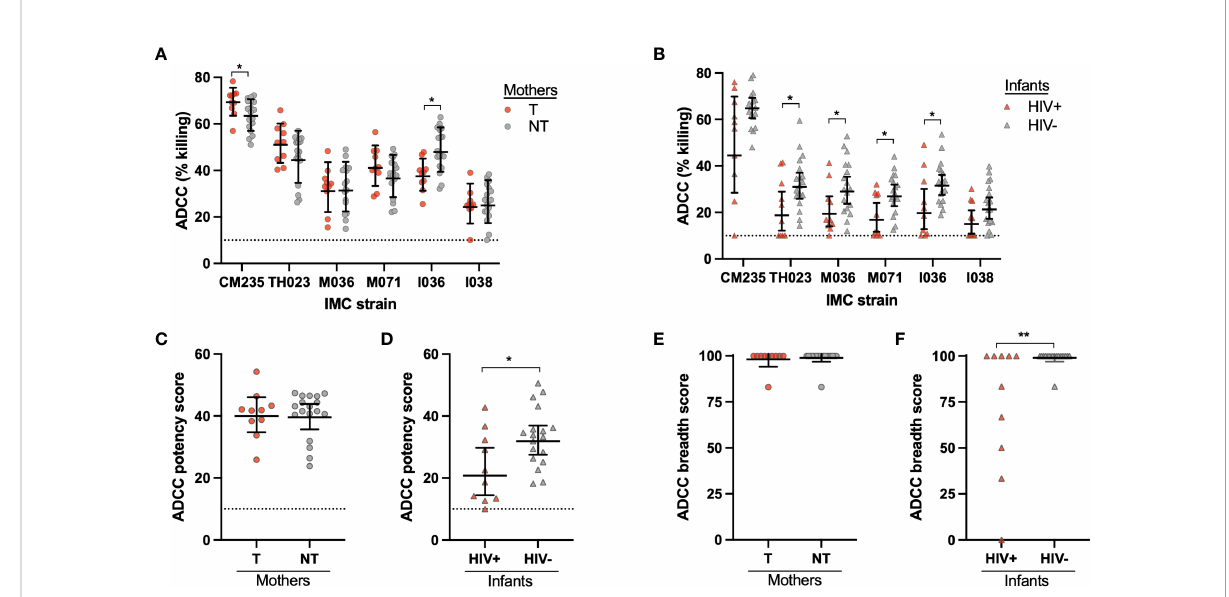
FIGURE 1 Mother and infant plasma ADCC activity. ADCC activity was measured for the (A) transmitting (T) and non-transmitting (NT) mothers and (B) HIV + and uninfected (HIV-) infants using six CRF01_AE HIV strains in the ADCC-Luciferase assay. CRF01_AE HIV IMC strains CM235, TH023, M036, M071, I036, and I038 were used; M036 and M071 were originally isolated from the maternal cohort, and I036 and I038 were originally isolated from the infant cohort. The ADCC potency was calculated as the geometric mean of ADCC % killing for all IMC strains for the (C) mothers and (D) infants. The ADCC breadth score was determined as the percentage of IMC for which ADCC activity was observed for the (E) mothers and (F) infants. The dotted line at 10% killing indicates the negative cut off value for the assay. Signi fi cant differences were determined by Mann- Whitney test and are indicated by * above the plots; * = p < 0.05, ** = p <